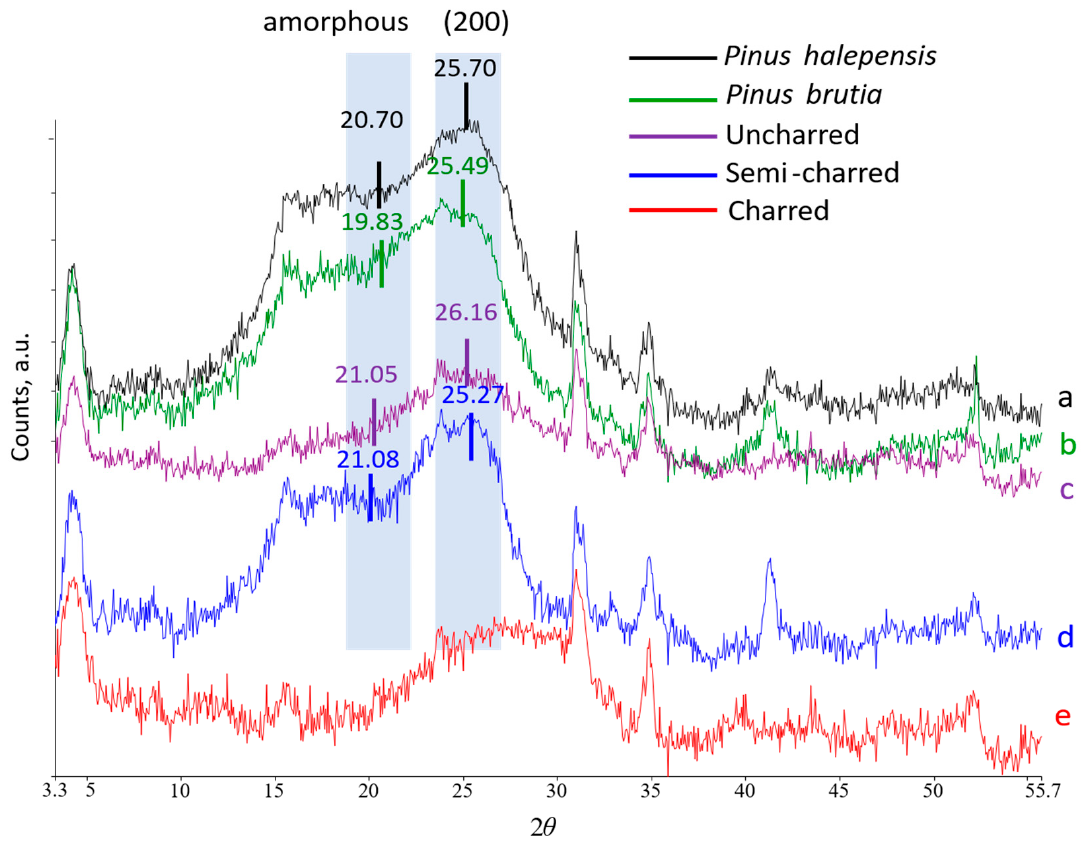
Figure 5. X-ray diffraction pattern of ( a ) Pinus halepensis and ( b ) Pinus brutia reference samples in comparison with ( c ) uncharred, ( d ) semi-charred, and ( e ) charred waterlogged samples. The 2 θ values correspond to Cobalt source reflections.